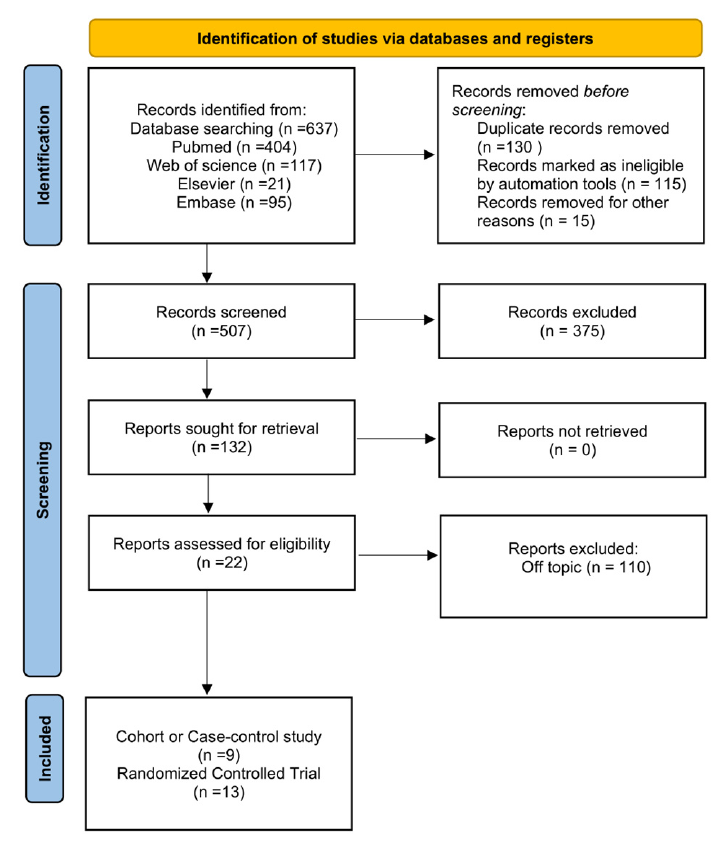
Figure 1. Flowchart of the meta-analysis study selection process.